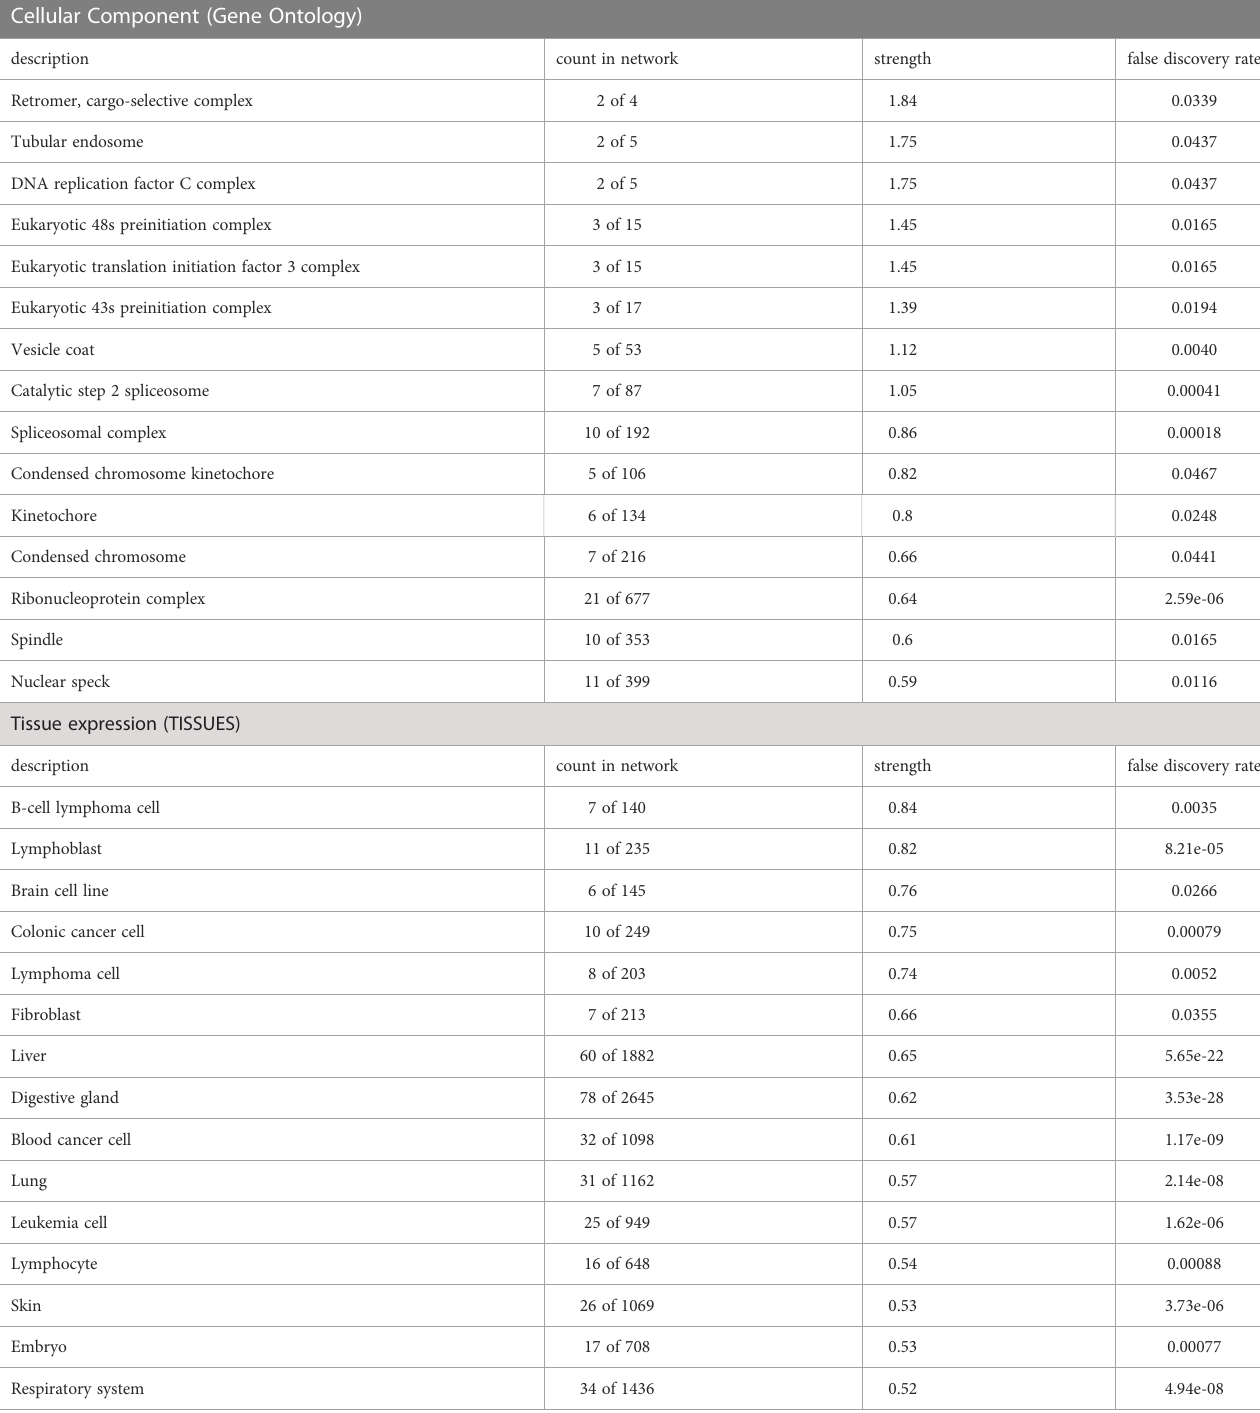
TABLE 2 String-DB (https://string-db.org/) functional enrichment analysis of cellular proteins with decreased ubiquitination in the presence of Nef identi fi ed signi fi cant enrichment in 35 cellular components, 48 tissues, 97 biological processes, 26 molecular functions, and 24 Reactome pathways, based on the 140 out of 232 proteins identi fi ed in the